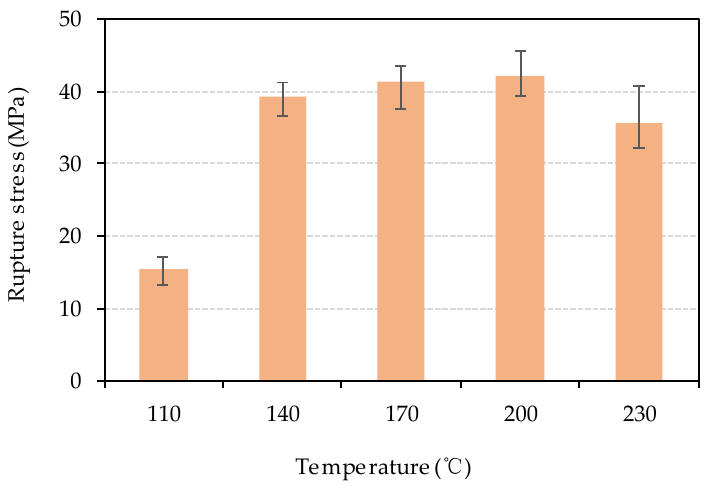
Figure 10. Bending rupture stress of bio-board at different temperature (P < 0.05).